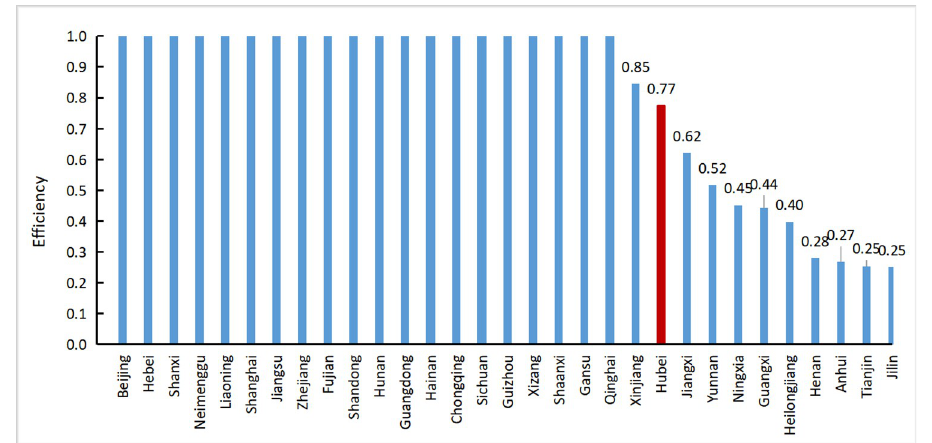
Fig 2. Ranking map of agricultural carbon emission efficiency of 31 provinces in 2018.